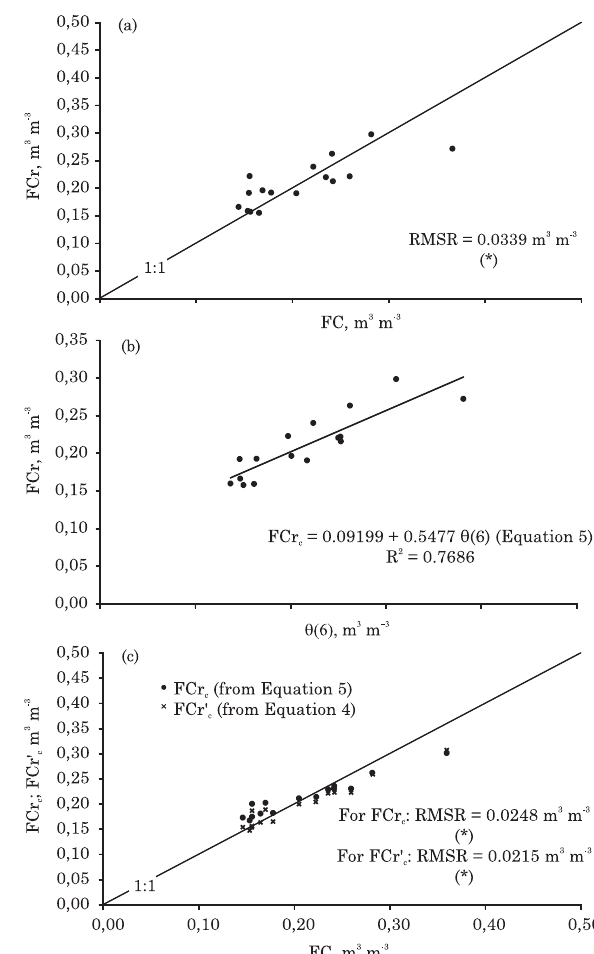
Figure 4. Relationships involving standard field capacity (FC), ring field capacity (FCr), and θθθθθ (6) data for soils P15 and P36 (n=16). In (a), FC is compared to FCr. In (b), the local regression equation for FCr vs θθ θθθ (6) (Equation 5) is represented. In (c), the values determined by equations 5 and 4 are evaluated in comparison to the FC data. *: means that the variable at the vertical axis is statistically indistinguishable from FC (at p<0.05), according to the Wilcoxon